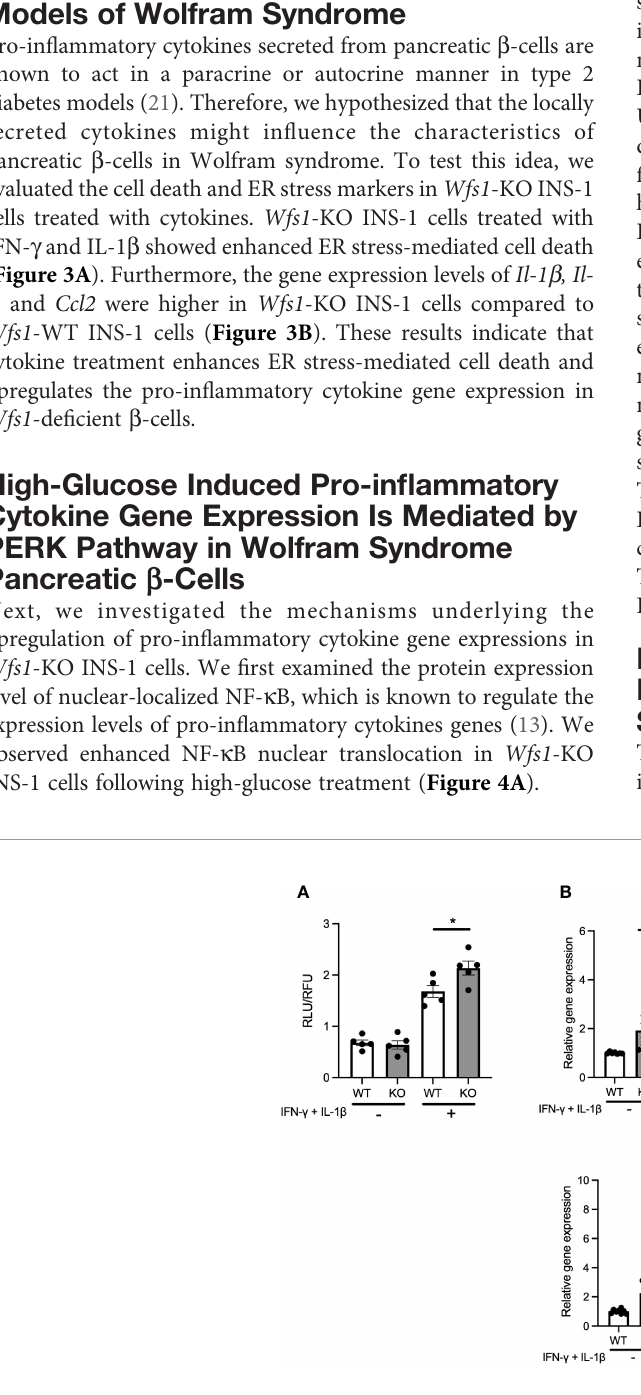
FIGURE 3 | Cytokine treatment causes ER-stress induced cell death and pro-in fl ammatory cytokines gene upregulation in Wfs1 -de fi cient pancreatic b -cells. (A) Caspase-3/7 activity normalized to cell viability in Wfs1 wild-type (WT) and knock-out (KO) INS-1 832/13 cells treated with IFN- g (50 ng/mL) and IL-1 b (50 ng/mL) for 24 h (n=5). (B) mRNA expression level of Chop , Il-1 b , Il-6 , and Ccl2 in WT and KO INS-1 832/13 cells treated with IFN- g (50 ng/mL) and IL-1 b (50 ng/mL) for 24 h (n=6-8), normalized to 18srRNA . Data are shown as mean ± SEM, *P < 0.05, **P < 0.005, ***P <